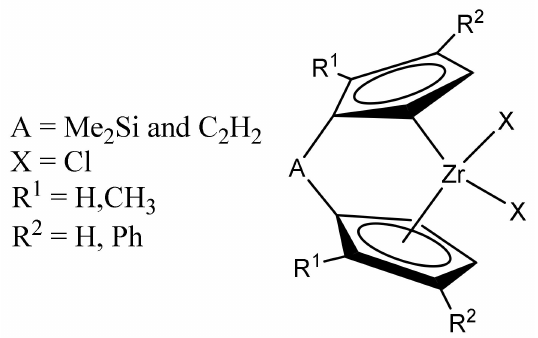
Figure 1. Structure of the metallocene